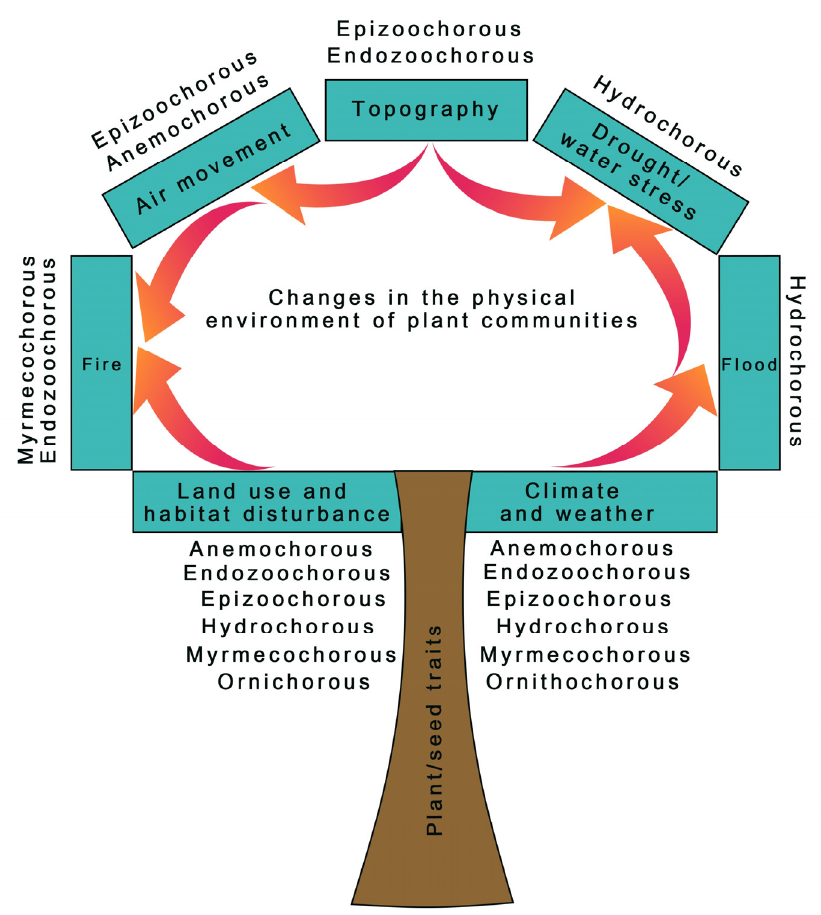
Figure 3. Diagram of seven environmental factors influencing seed dispersal modes of different plant groups. The arrows represent the interactions among factors.